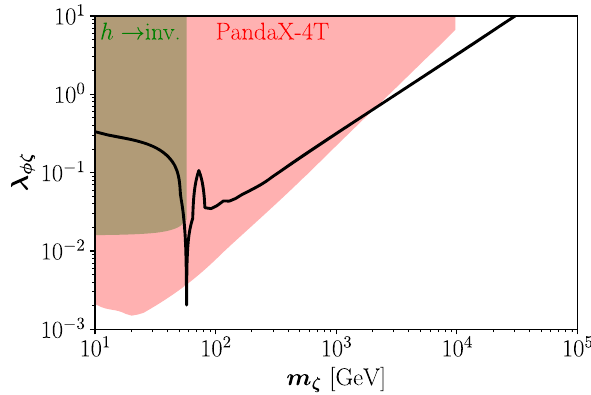
Fig. 3 ScalarDM.Parameterspacethatreproducesthewholeobserved DM abundance (black thick line). The color-shaded areas are in tension with the invisible decay of the Higgs (brown) or PandaX-4T results